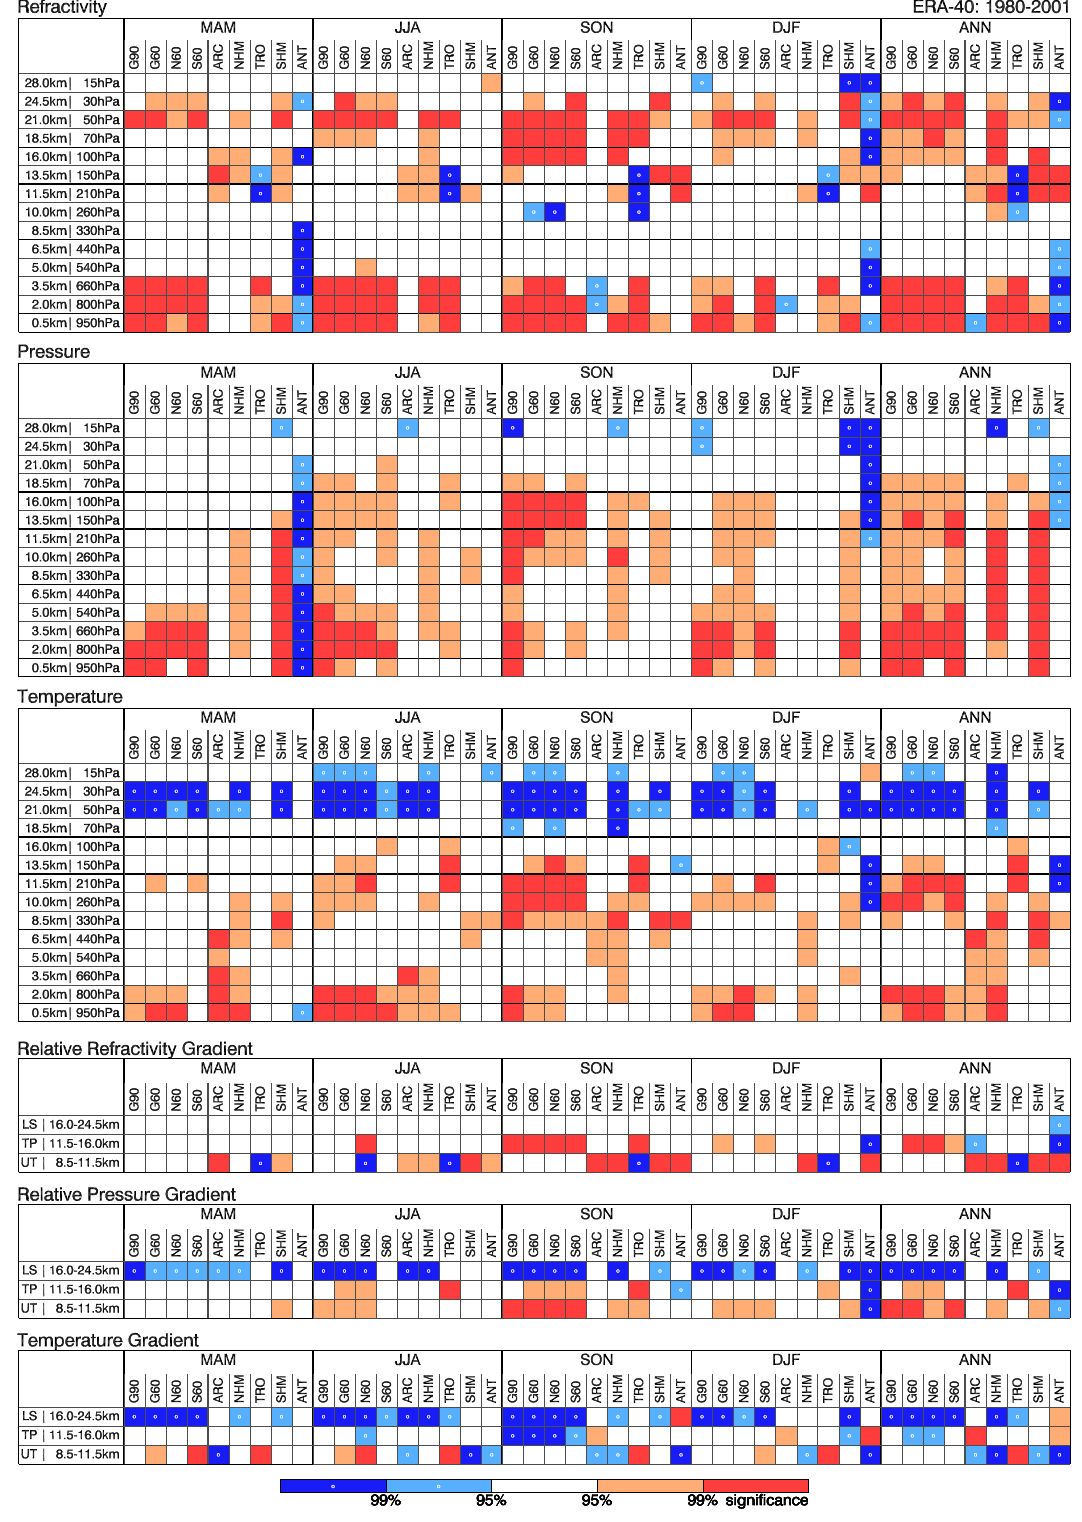
Fig. 9. Trend indicators based on ERA-40 for the period 1980 to 2001 for the RO-accessible variables refractivity, pressure, temperature, relative refractivity gradient, relative pressure gradient, and temperature gradient (from top to bottom). Same layout as Fig.